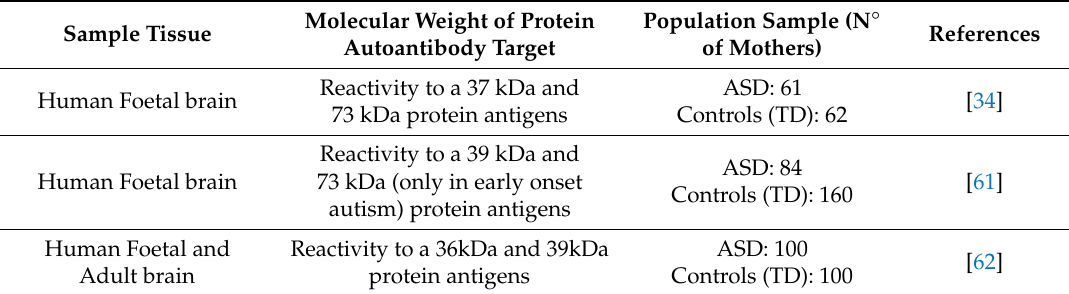
Table 2. Observational studies looking at protein antigen targets for autoantibodies from mothers of children with ASD and mothers of typically developing children